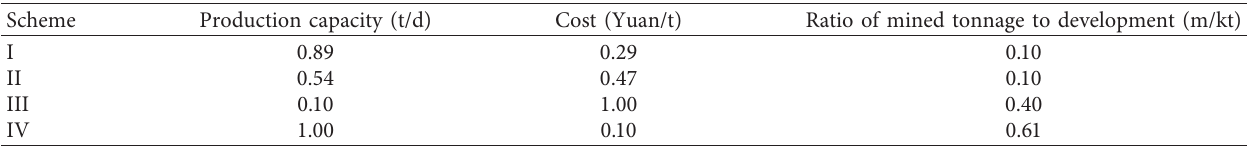
Table 4: Normalization of the economic